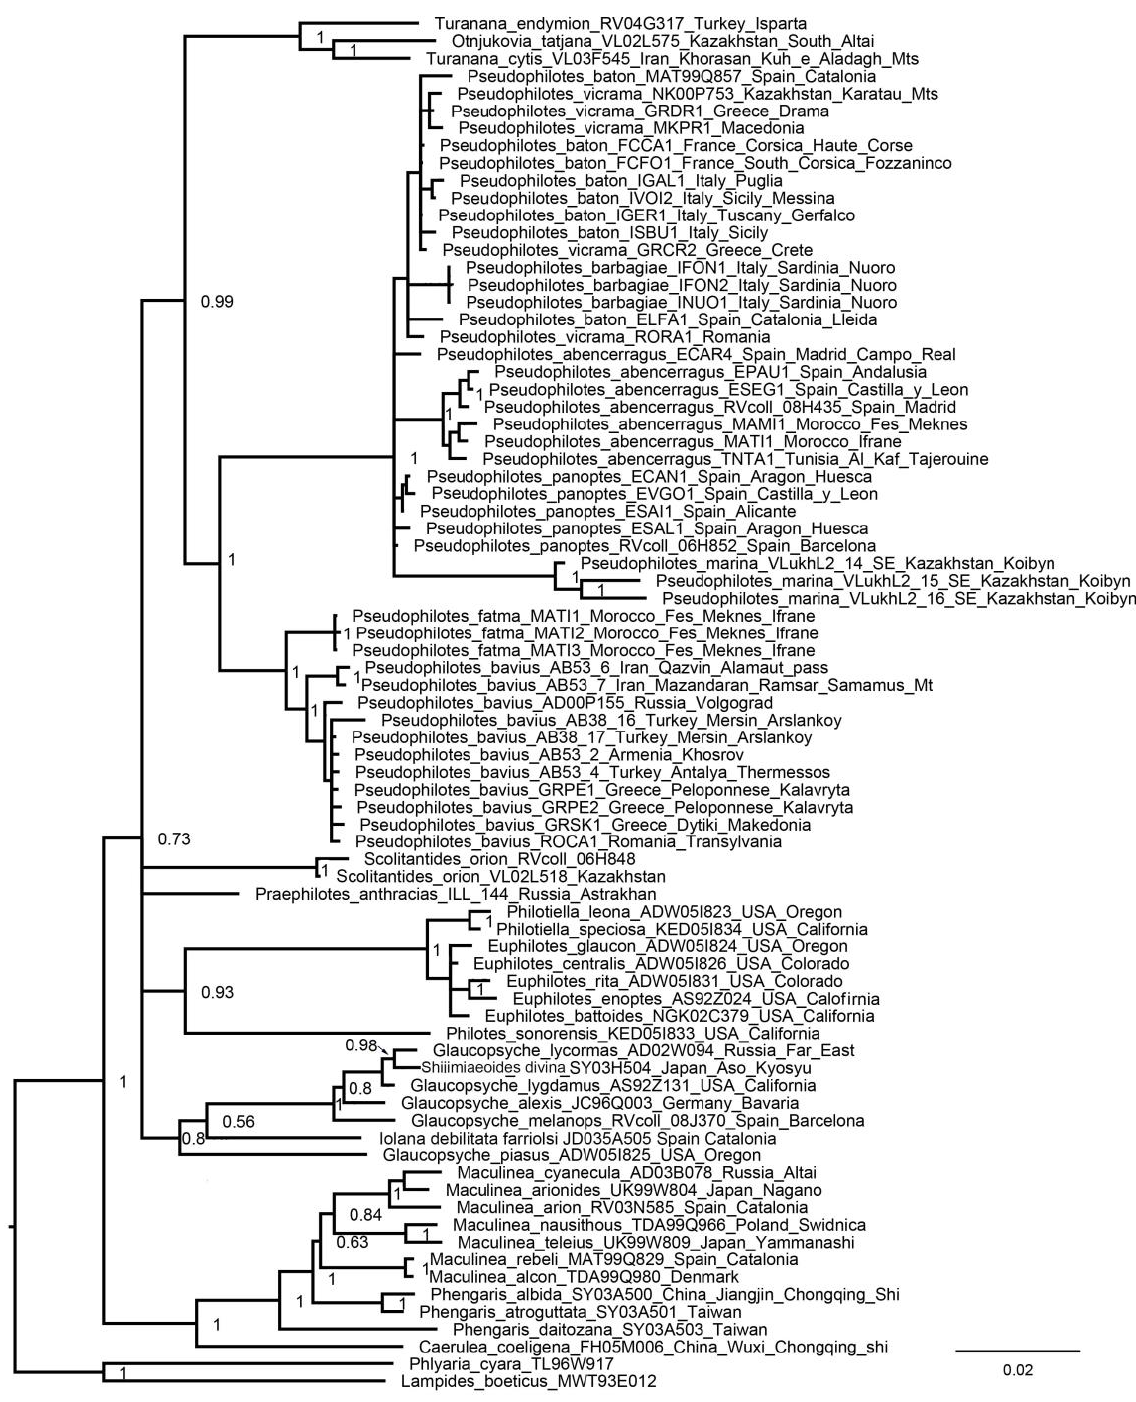
Figure 2. BI tree of the subtribe Scolitantidina based on nuclear sequences ( 28S + H3 + EF1-a + wing- less + ITS2 dataset). Posterior probabilities are indicated at the nodes.